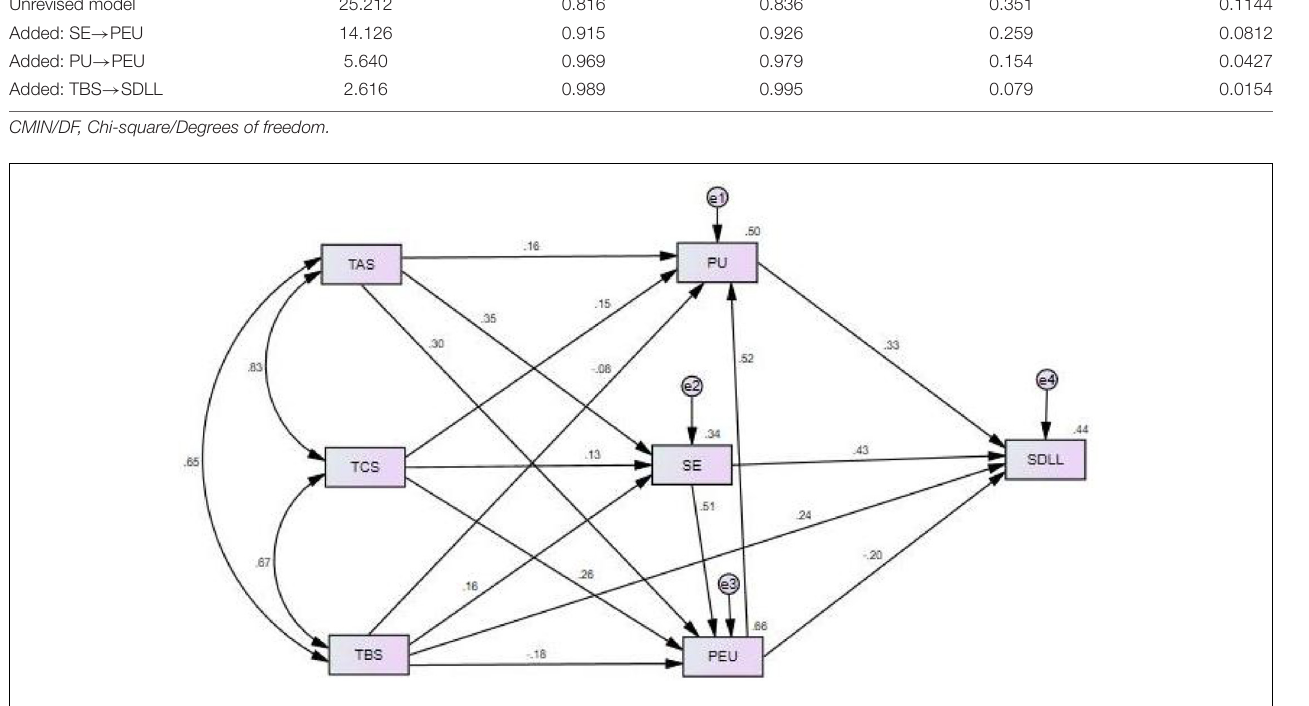
FIGURE 2 | The modified